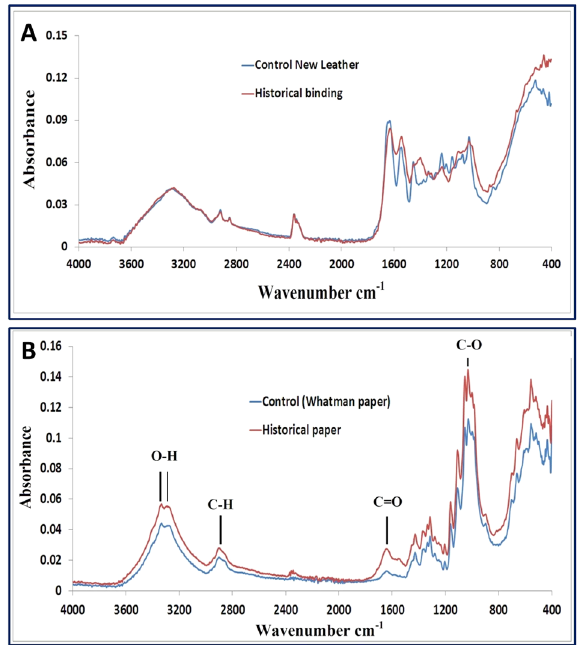
Fig. 3 ART-FTIR chart of historical leather and papers compared to control. A Is the ART-FTIR of historical and control leather, B is the ART-FTIR of historical paper and Whatman paper